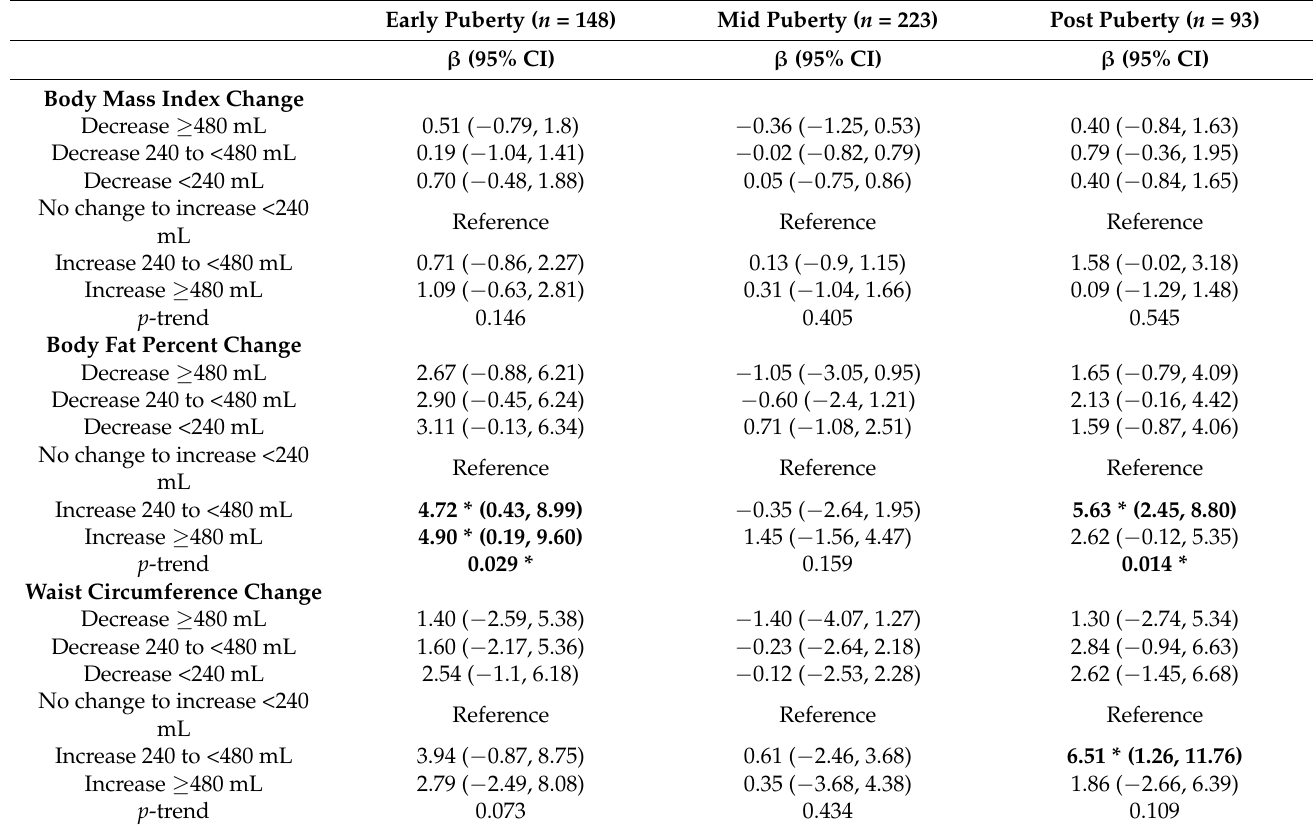
Table 4. Linear regression between body composition change and SSB intake change, stratified by pubertal stage ( n =